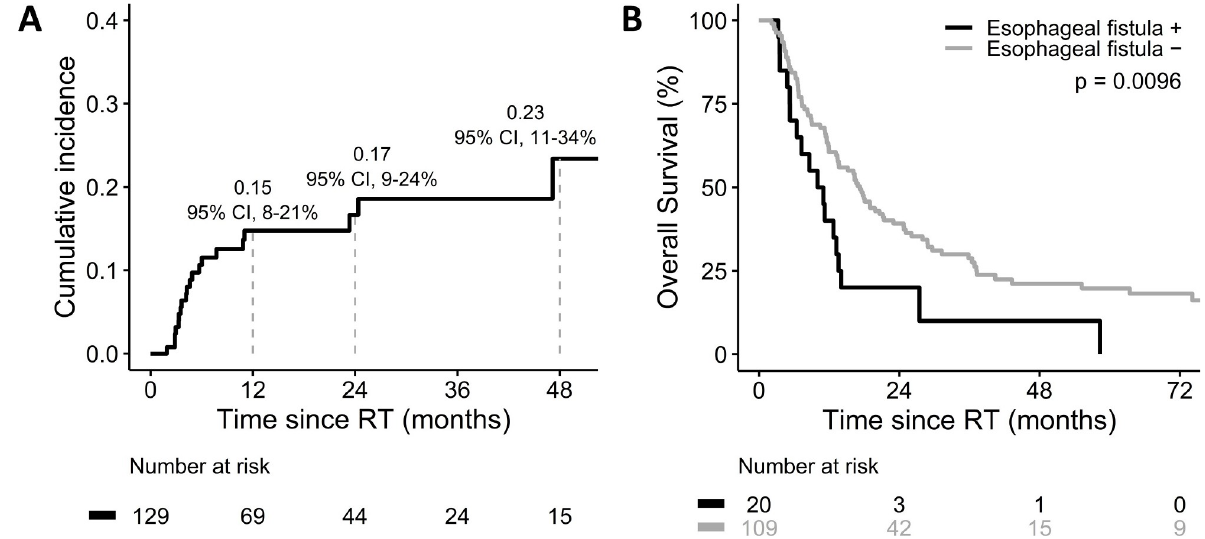
Fig 1. (A) Cumulative incidence of esophageal fistula. (B) Overall survival by esophageal fistula .